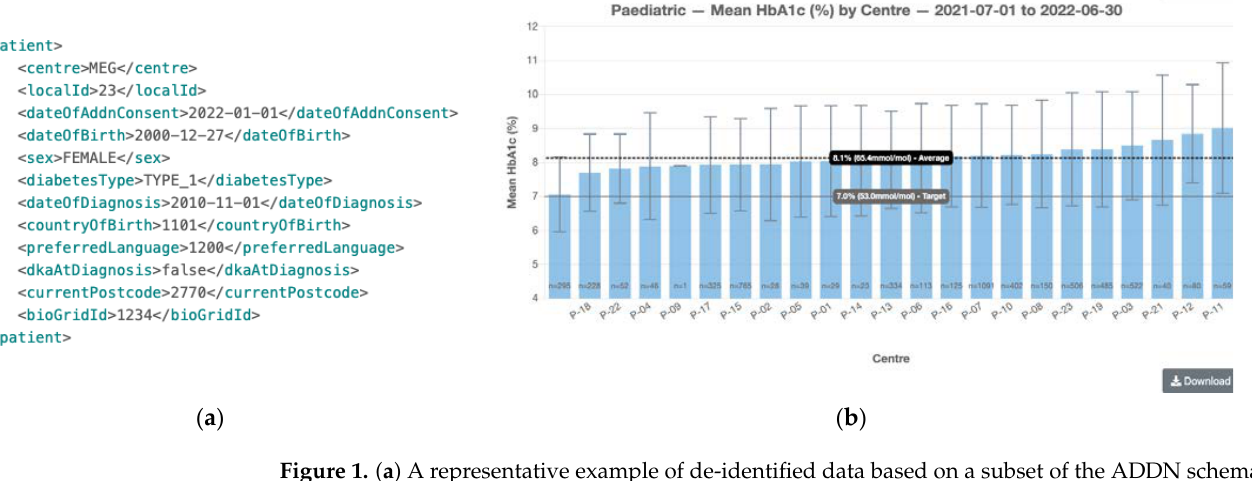
Figure 1. ( a ) A representative example of de-identified data based on a subset of the ADDN schema. ( b ) A screenshot of the HbA1c section of the benchmarking report. “P-“ indicates a paediatric